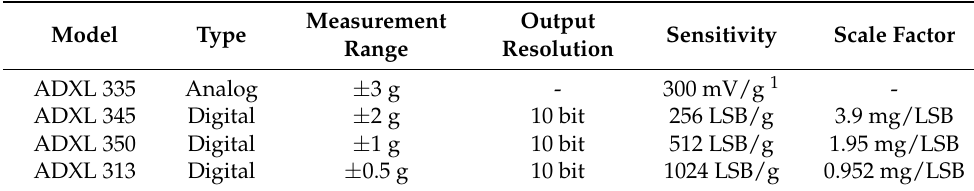
Table 1. Main features of the accelerometers by Analog Devices considered for the application proposed here.